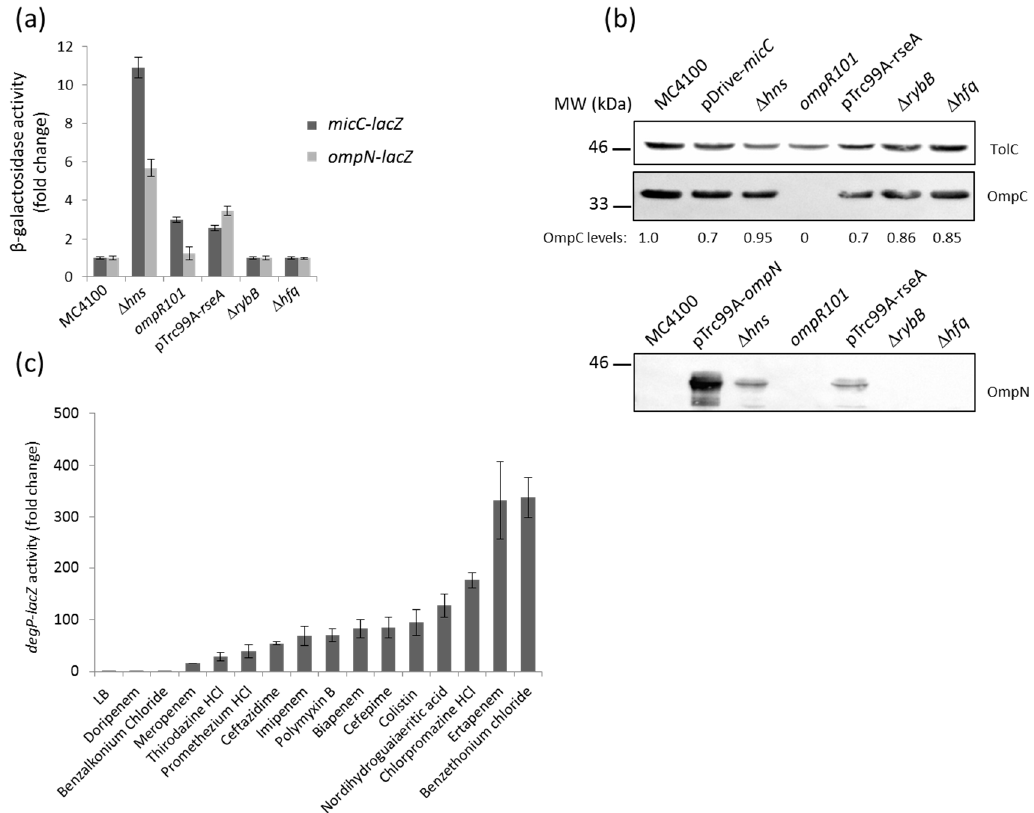
Figure 3. ( a ) β -Galactosidase activity of the micC– and ompN–lacZ fusions in different genetic backgrounds. Envelope stress sigma factor σ E is essential in Escherichia coli . Therefore, cells were temporarily depleted of σ E by the overexpression of the anti-sigma factor RseA with 0.4 mM IPTG under heat shock conditions at 42 ◦ C; ( b ) WB analysis of OM proteins. Cells were grown, and OM extracts were prepared as described in the Materials and Methods. OM proteins equivalent to 0.2 ODU of cultures were separated by SDS-PAGE, electrotransferred on nitrocellulose membranes, and blotted with the appropriate anti-sera. Data show the production of OmpC (upper panel) and OmpN (lower panel). TolC expression was evaluated for normalizing sample loading and the expression of normalized OmpC has been expressed in numerical values below the bands; ( c ) β -galactosidase activity of a degP–lacZ chromosomal fusion in response to various external stresses.